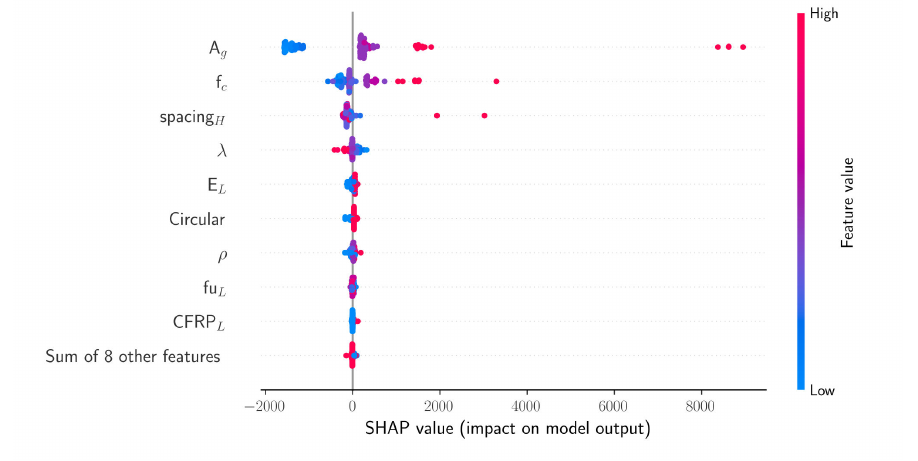
Figure 4. SHAP values of the design variables for the XGBoost model.